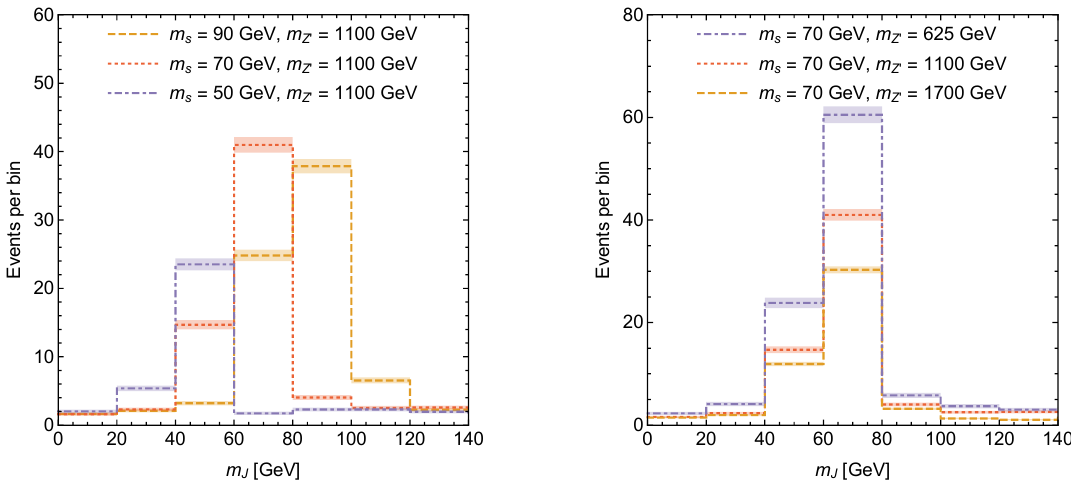
Figure 4 . Distribution of m J for signal models with di(cid:11)erent dark Higgs mass (left) and with di(cid:11)erent Z 0 mass (right) and an integrated luminosity of 40 fb (cid:0) 1 . In both (cid:12)gures we only consider events with =E > 500 GeV. T